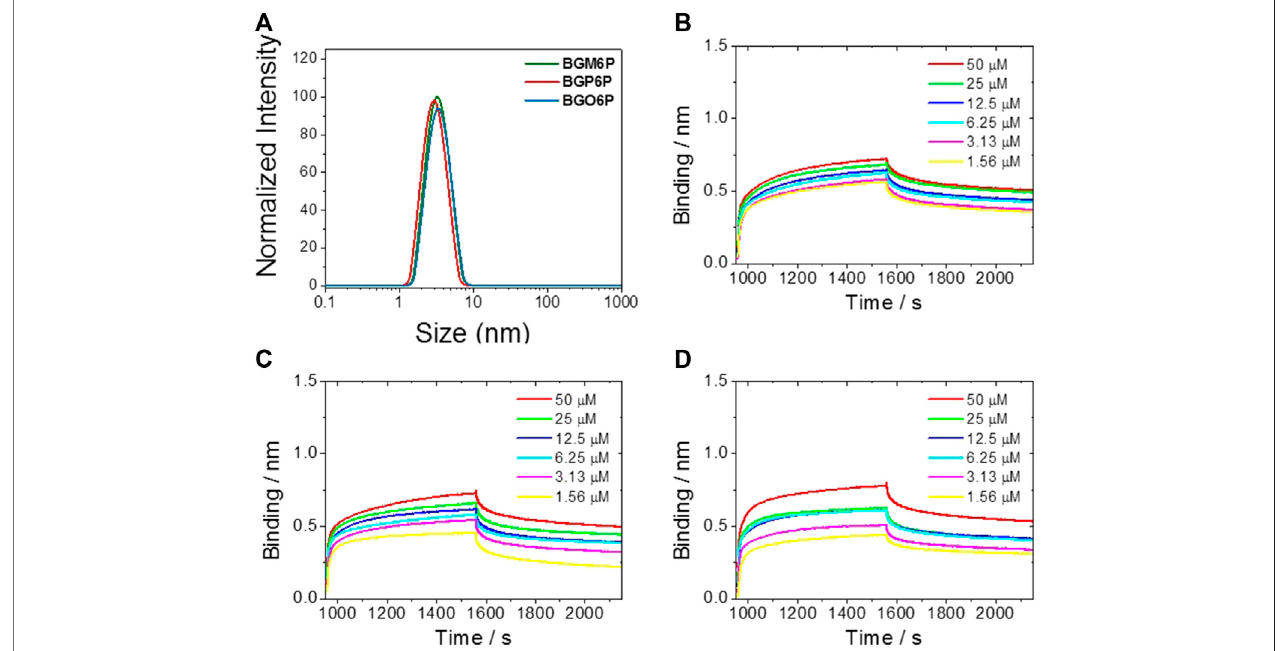
FIGURE 5 | (A) Size of fl uorophores tested by dynamic light scattering (DLS) method. Kinetic binding assay to albumin results of BGM6P (B) , BGP6P (C) and BGO6P (D) measured by bio-layer interferometry.